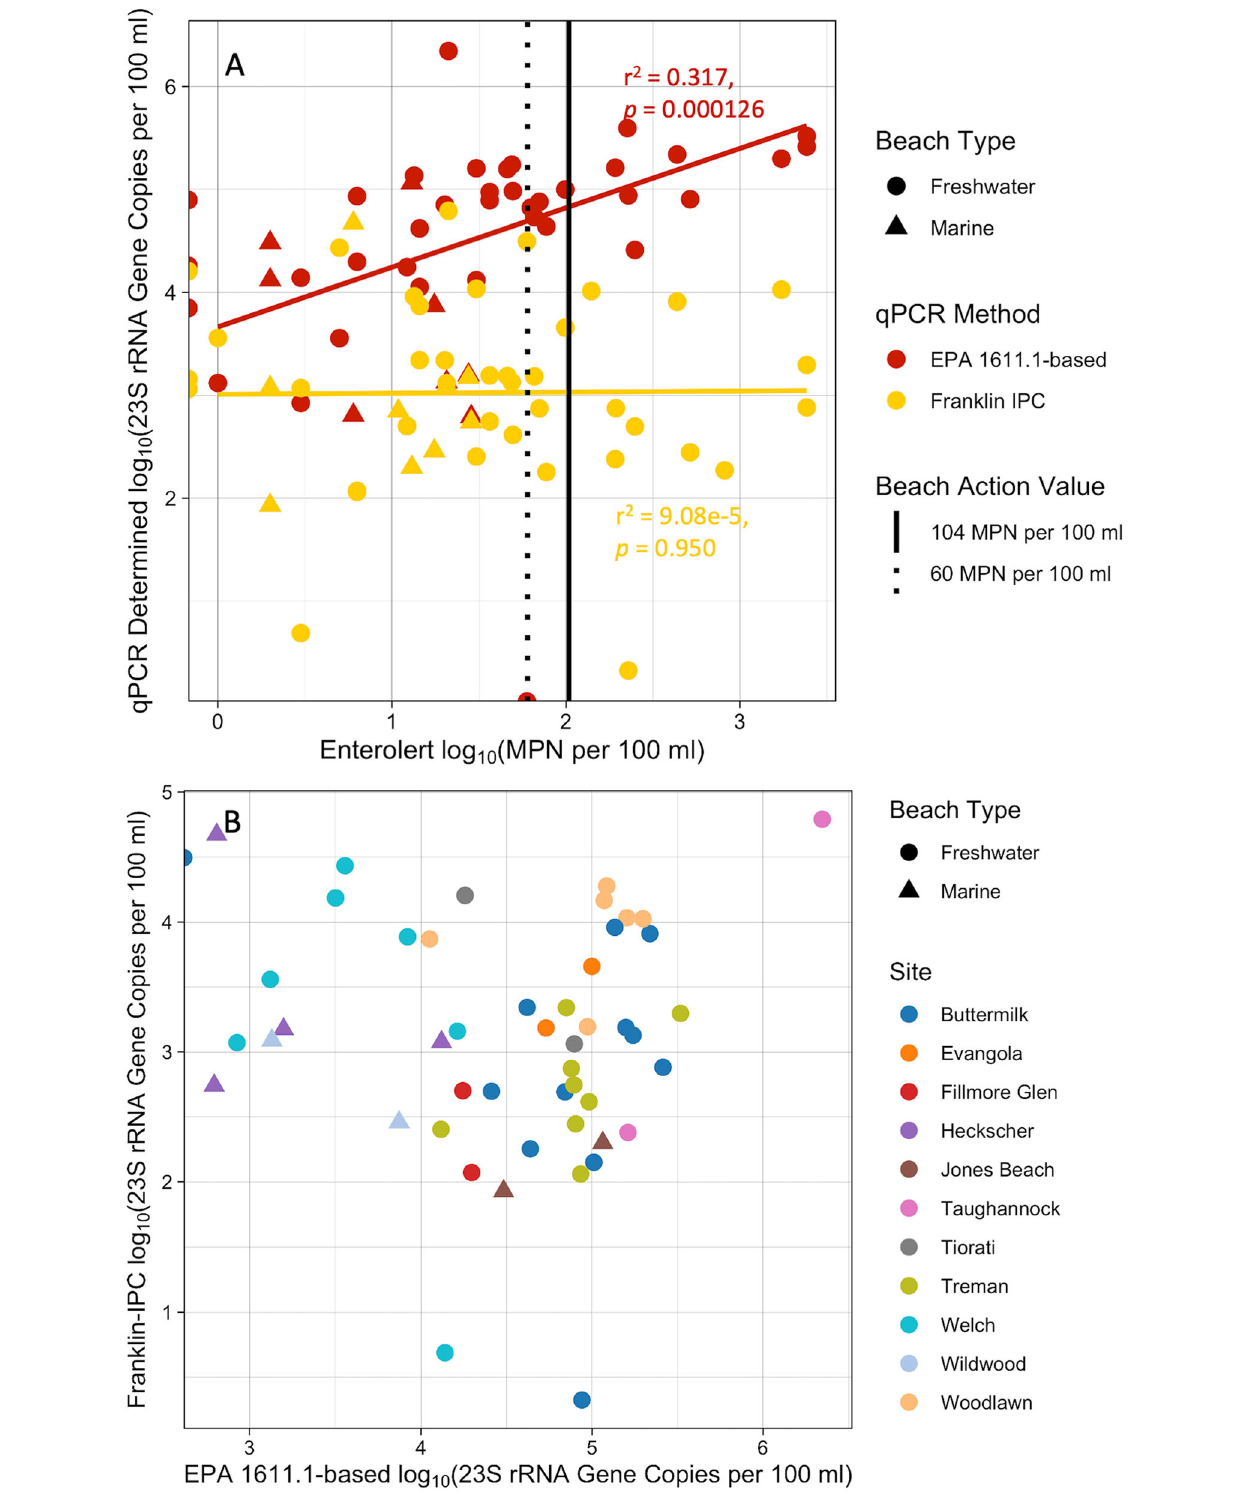
FIGURE 6 | Summer 2018 water sample results from 12 New York State beaches. (A) Comparison of qPCR methods EPA-based and Biomeme Franklin-IPC (Methods B and C2-IPC) to Enterolert. Vertical lines denote beach action values (BAVs) used by different localities, the dotted black line represents a BAV of 60 MPN per 100ml and the solid line represents a BAV of 104 MPN per 100ml. (B) Comparison of qPCR methods: Biomeme Franklin-IPC with EPA 1611.1.